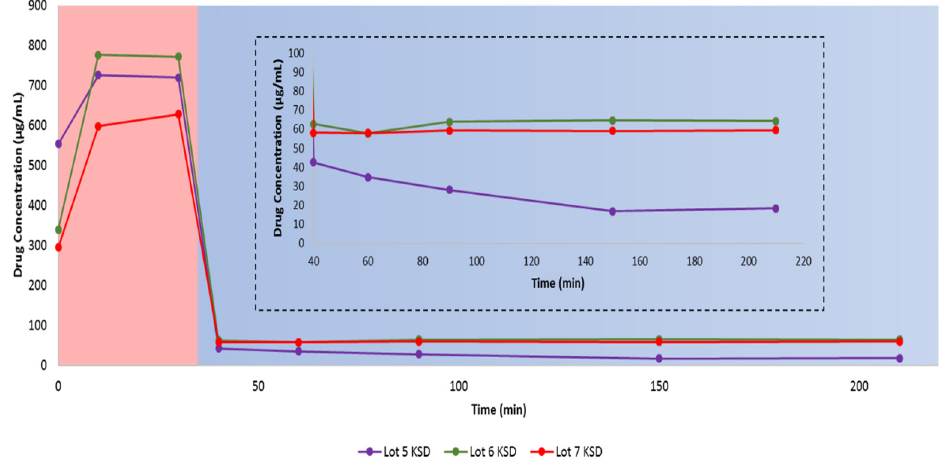
Figure 8. In vitro, non-sink, gastric transfer dissolution profiles of the Lots 5, 6, and 7 KSDs. Red region: 0.01 N HCl. Blue region: FaSSIF. The inset represents the enlargement of the dissolution profile in FaSSIF.